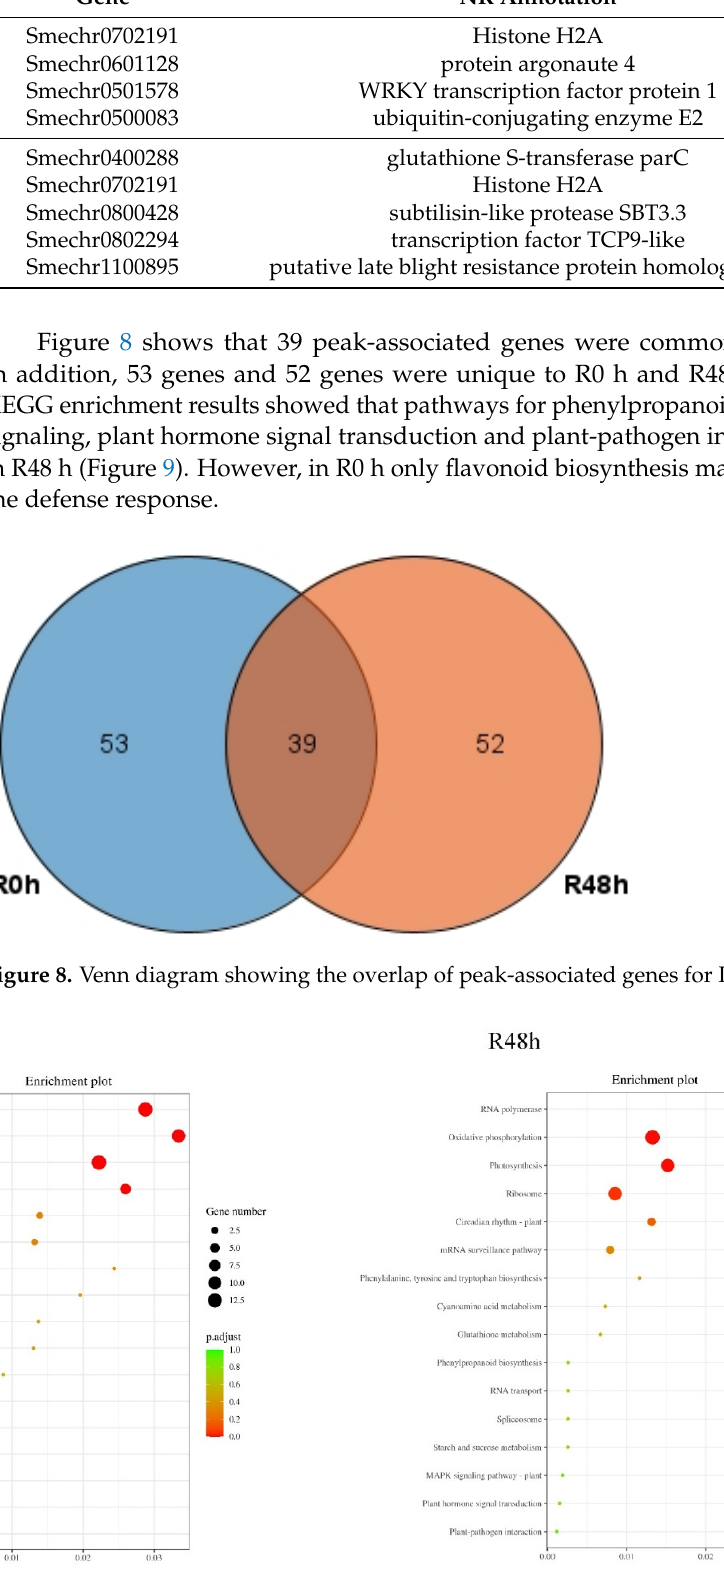
Figure 9. KEGG enrichment pathways for the peak-associated genes in R0h and R48h. The motifs in the promoter region were analyzed using Homer software by de novo methods. There was a total of 17 and 22 predicted motifs in R0h in R48h, respectively, and only one motif (Bach2 (bZIP)/OCILy7-Bach2-ChIP-Seq (GSE44420)/Homer (0.746)) was identified in both R0h and R48h. All motifs were identified in JASPAR CORE plants or yeast, where two R48h motifs were identified as TCP binding motifs (Tables S5 and S6). 2.6. Differences in Peaks between R0h and R48h The difference in the peaks between R0h and R48h was detected by the Diffbind R package with a p -value < 0.05 and fold > 0 [30]. A total of 89 different peaks were identi- fied, 48 of which were up-regulated and 41 were down-regulated (Table S7). However, 86 peaks were located in the intergenic region and only 3 peaks were located in the pro- moter region (Figure S2). One of the gene modules (Smechr0702191) was annotated as histone H2A and the others were annotated as uncharacterized proteins (Table 3). Table 3. The difference in peak-associated genes between R0h and R48h. Gene ID